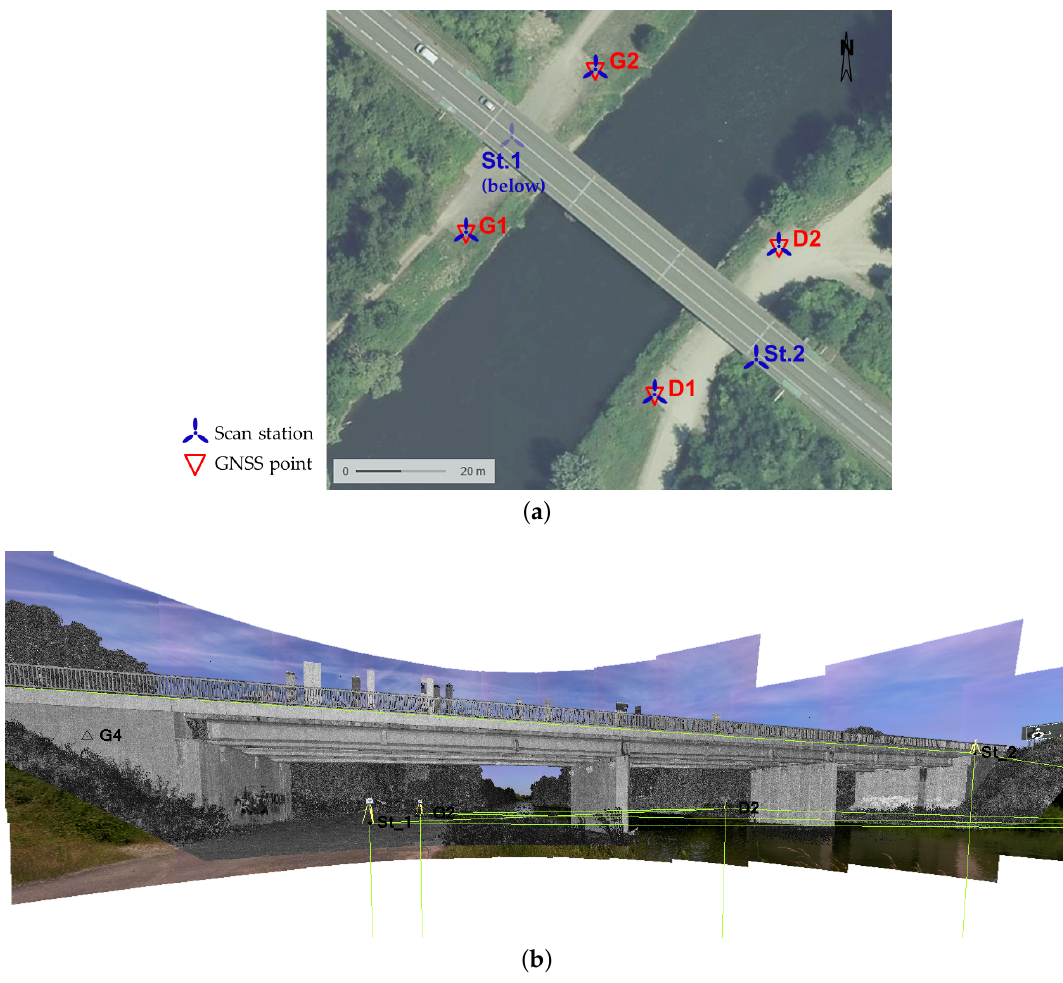
Figure 6. ( a ) Overview of the area around surveyed bridge with four of the Global Navigation Satellite Systems (GNSS) reference points; ( b ) Station view captured from Trimble Business Center office software. Georeferenced point cloud (in grey) and images are visible as seen from the considered station (station G1 in this